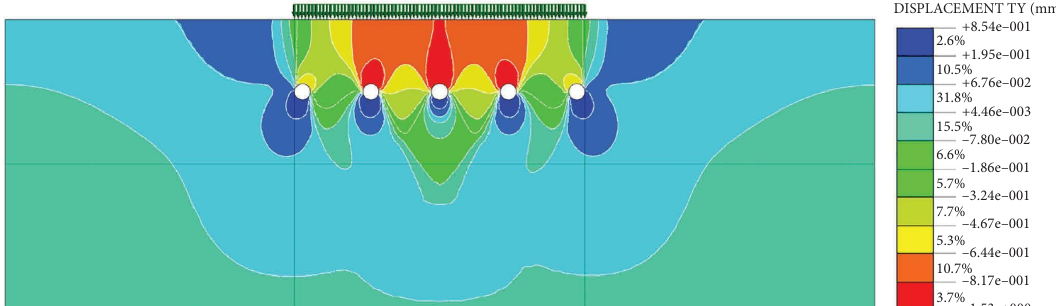
Figure 4: Simulated settlement after